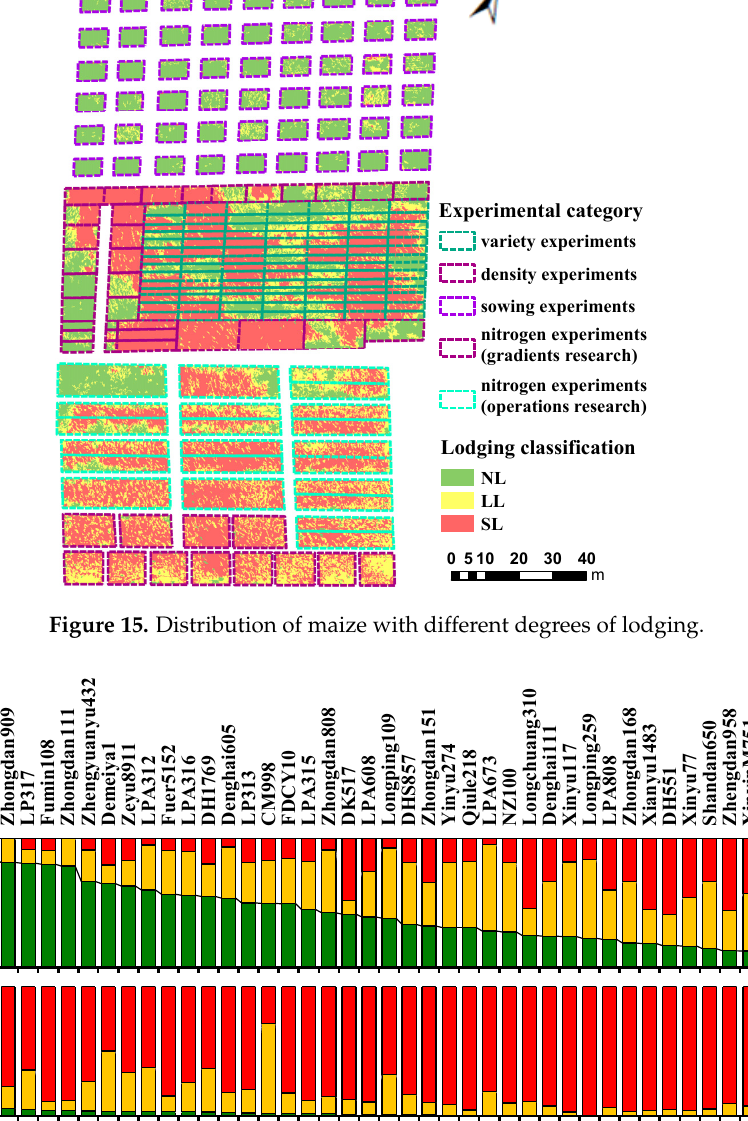
Figure 17. Spatial distribution of the 20 maize varieties most resistant to lodging. In the sowing-date experiment, the aisles or gaps between plots lead to a lodging fraction and degree of lodging that is far less than in the other experimental plots. These plots experienced only a small amount of LL and a small amount of SL. The lodging re- sistance of the three varieties remains essentially the same over the eight sowing dates. The fifth, sixth, and seventh stages are lodging-prone (i.e., R1, VT, and V14; see Figure 18). Figure 19 compares the maize lodging under different nitrogen treatments. The re- sults of nitrogen gradient treatment indicate that increasing the total nitrogen amount im- proves the lodging resistance of maize and decreases the fraction of SL. However, no sig- nificant change occurs in the range of NL.